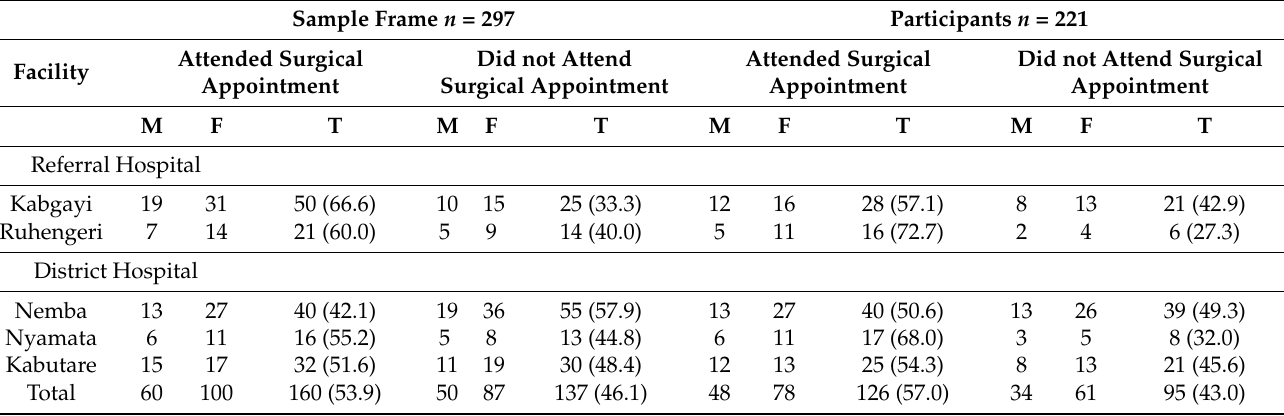
Table 1. Summary of the sample frame and participants by attendance at cataract surgery appointment, May–July